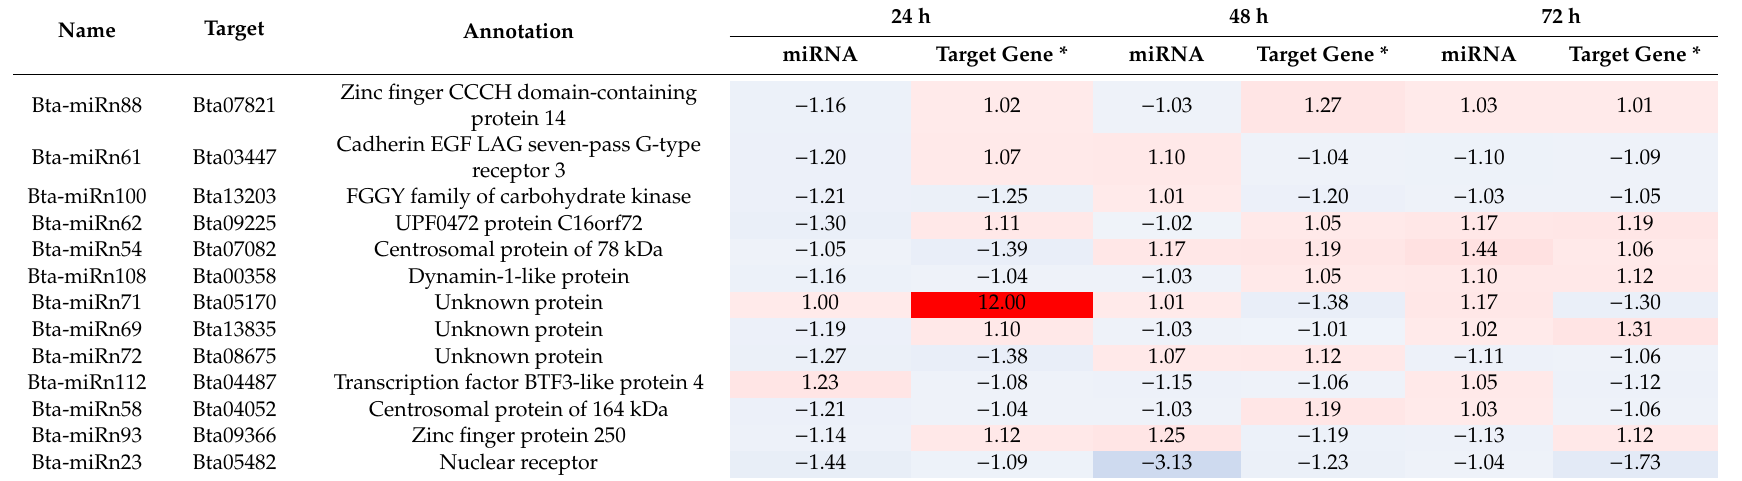
Table 2. Fold change values for novel miRNAs and their predicted single target genes in whiteflies ( B. tabaci ) fed on TYLCV-infected